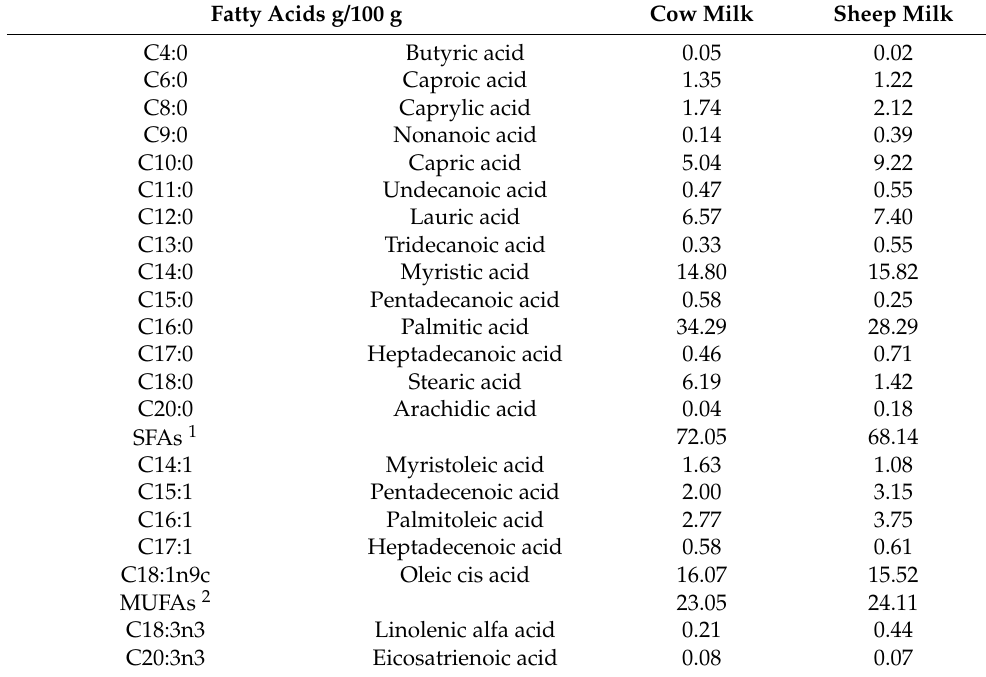
Table 4. Fatty acid profiles for cow and sheep milk samples ( n = 3). Fatty Acids g/100 g Cow Milk Sheep